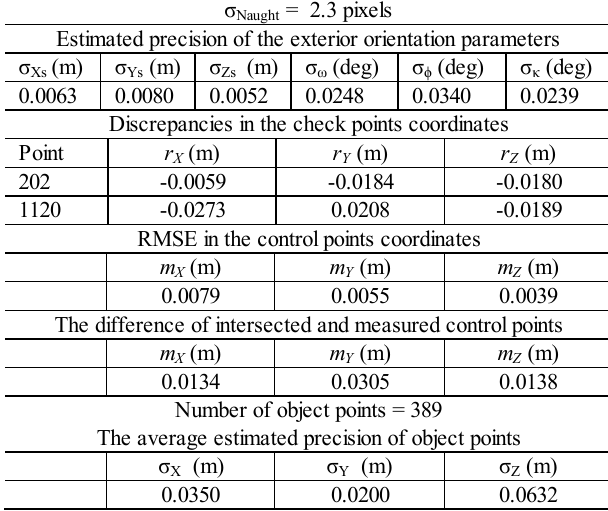
Table 4. Results of the bundle adjustment with the resampled